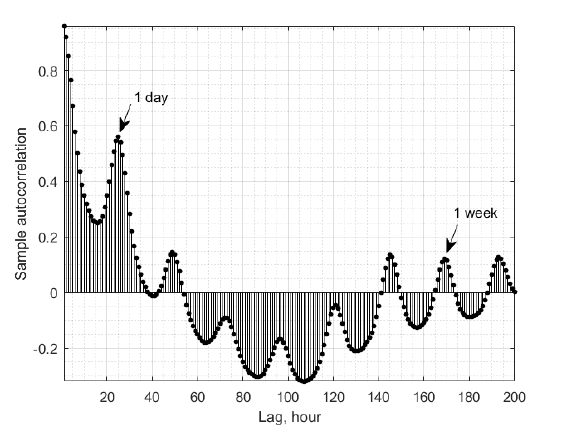
Figure 4 . Autocorrelation of PM 2.5 temporal variation 2) Long-term consistency and short-term differences among different stations. Shape distances and piecewise linear representation results show that, among all stations in the network, wavelet components of PM variations at 7-day or longer periods are identical in terms of overall temporal patterns; those at 4-hour or shorter periods are different from each other.